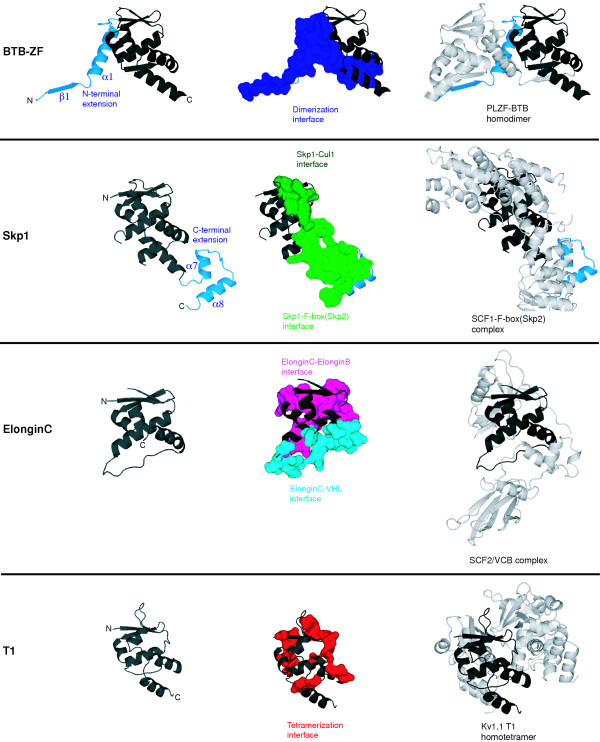
Protein-protein interaction surfaces in BTB domains. Left column: the BTB monomer is shown in the same orientation for each of four structural families with the core fold in black, and the amino- and carboxy-terminal extensions in blue. Middle column: the monomers are shown with the protein-protein interaction surfaces shaded. Right column: the monomers are shown in their protein complexes.